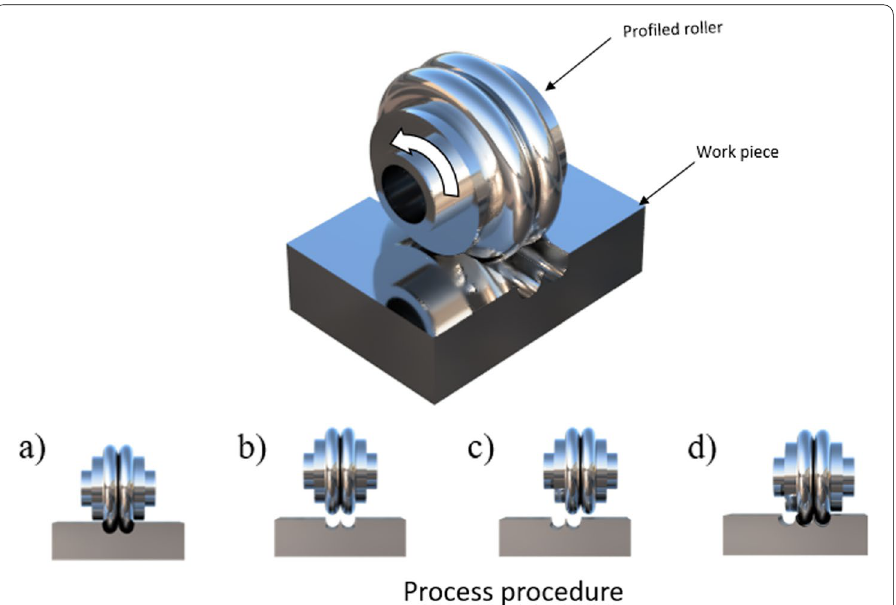
Fig. 5 Isometric view of the profiled roller and process of Incremental riblet rolling. a The grooved roller is rolled over a workpiece surface. b Roller is moved up. c Roller is positioned for next grove. d Roller is